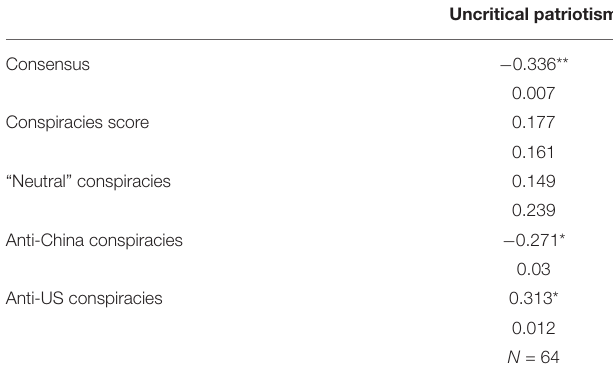
TABLE 3 | Relationship between uncritical patriotism and belief in various conspiracy theories among Chinese living in